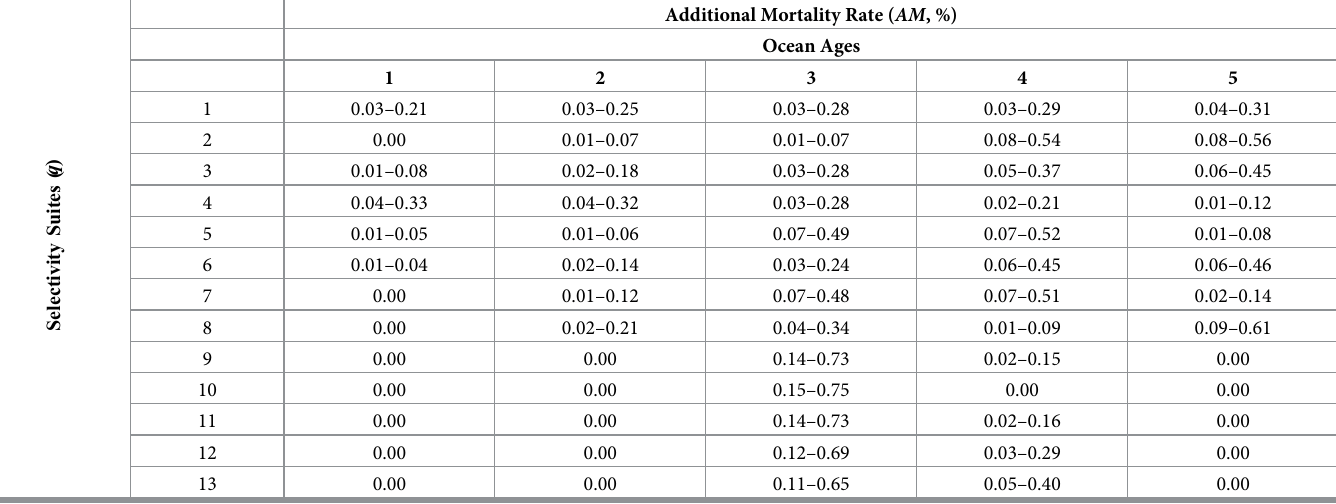
Table 2. The range of annual mortality rates (%) produced by all scenarios, excluding those which added zero additional mortality when environmentally driven and bycatch mortality are accounted for. Selectivity suites ( q a ) determine how additional late-stage mortality is applied to each ocean age class, and the range describes the simulated mortality across values of different intensities ( I